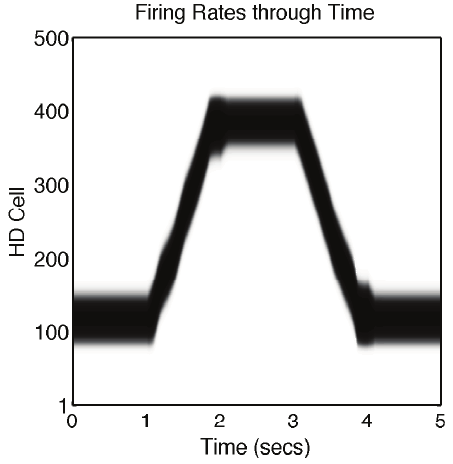
Figure 10. The firing rates of the head direction (HD) cells recorded during the testing phase. The rates are recorded from a model implemented with a uniform distribution of axonal conduction delays for w 2 and w 3 synapses within the interval from 1 ms to 100 ms. The model was trained with a rotational velocity of 360 o /s. Conventions are as for the top-right plots in Figures 7 and 8. It is clear from the plot that the model can learn to perform path integration of head direction when simulated with a range of axonal conduction delays.